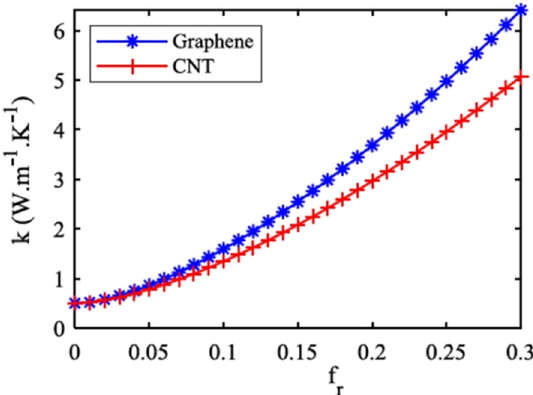
Figure 2: Thermal conductivities of graphene and CNT polymers versus volume fraction of nano fi llers [ 20 ]